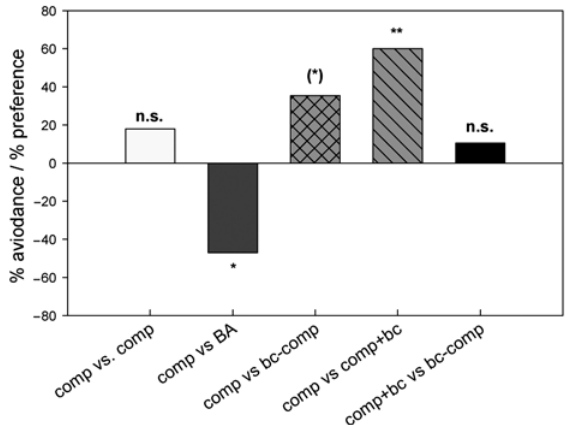
Fig. 3. Results of earthworm avoidance tests (method: ISO 17512-1:2008; Busch et al. 2012) with the compost (comp), biochar-compost (bc-comp) and compost with later addition of fresh biochar (comp+bc), material properties and composting described in Schmidt et al. (2014) and Kammann et al. (2015). “Comp vs. comp” is the control and did not result in an effect (as needed); boric acid (BA) was the “positive control” where avoidance behaviour confirmed that the test was valid. Bars give means of n = 5 repetitions per treatment (50 worms), shown as preference or avoidance of the respective substrate (Fishers exact test, (*) p < 0.1, * p < 0.05, ** p < 0.01, n.s.